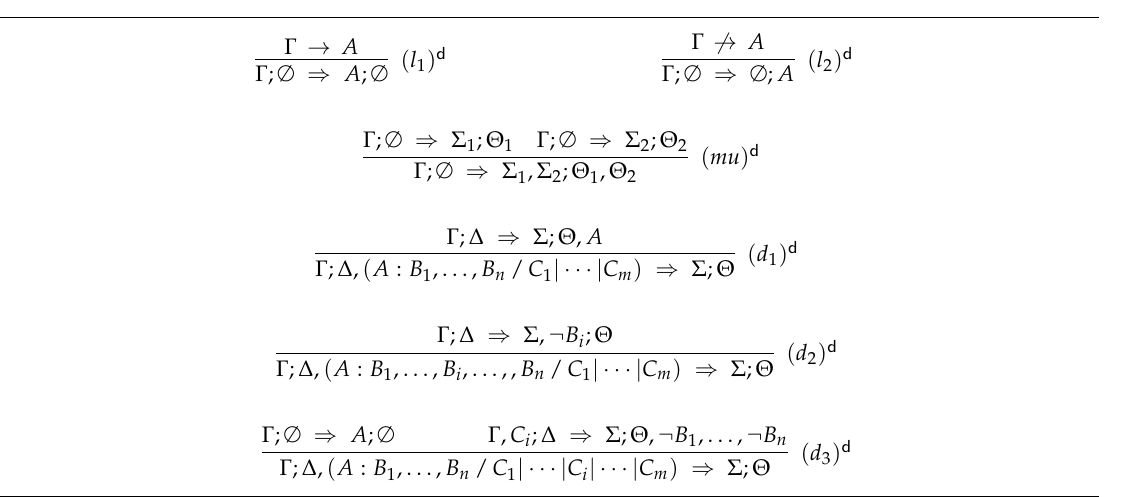
Figure 7. Additional rules of the calculus B D